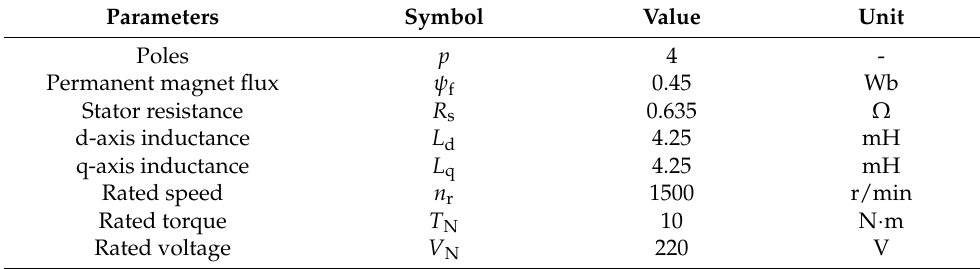
Table 5. Rated parameters of